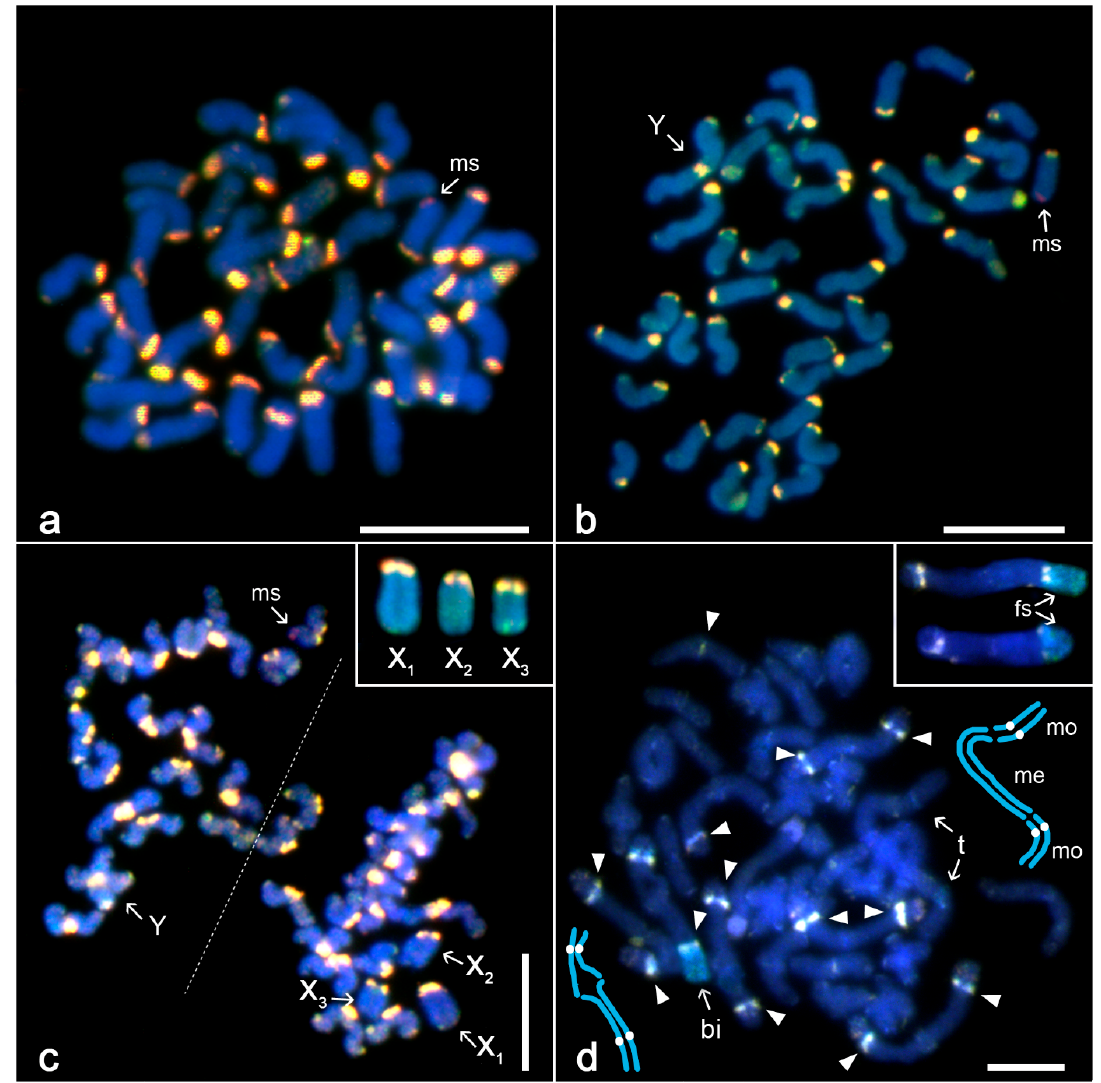
Figure 4. Comparative genomic hybridisation, spiders with neo-sex chromosome systems, male plates. Abbreviations: ms—male signal (red), fs—female signal (green). ( a – c ) Tegenaria ferruginea , centromeres are highlighted by both probes as a yellow block. In some chromosomes an arm is also terminated by yellow block. A small acrocentric chromosome exhibits male terminal signal on the long arm: ( a , b ) mitotic metaphase. Y chromosome bears two yellow blocks, centromeric and telomeric; ( c ) two sister metaphases II (separated by a dashed line). In contrast to other chromosomes, sister chromatids of multiple X chromosomes are attached. Inset: multiple X chromosomes, another metaphase II. ( d ) Atrophothele socotrana , diplotene. Centromeres of some bivalents are expressed as yellowish blocks (most prominent blocks are marked by arrowhead). Note a slightly heteromorphic bivalent (bi) and a trivalent (t). At left: schematic drawing of the heteromorphic bivalent (white dots—centromeres). At right: schematic drawing of the trivalent (me—metacentric chromosome, mo—monoarmed chromosome, white dots—centromeres of monoarmed chromosomes). Inset: two heteromorphic bivalents from other diplotene plates. Right chromosome of bivalent contains terminal (upper bivalent) or pericentric (lower bivalent) green female signal. Bar = 10 µ